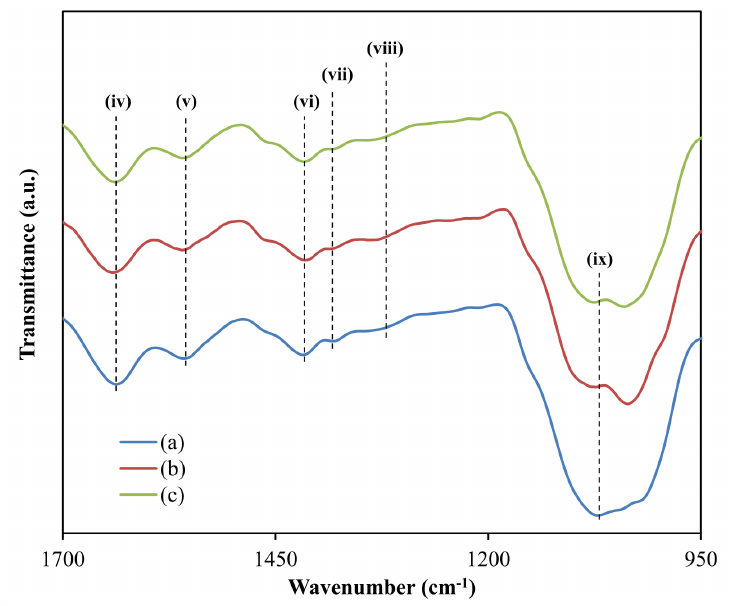
Figure 3. FTIR spectra at a wave number between 950 and 1700 for ( a ) CDLG–1, ( b ) CDLG–2, and ( c ) CDLG–3 plasticized electrolyte films.